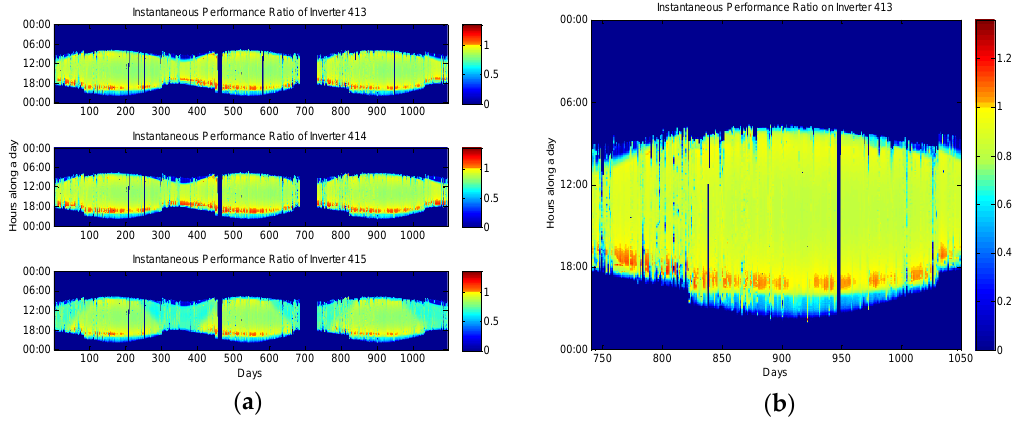
Figure 9. ( a ) Instantaneous values of performance ratio of the three inverters, during 24 h a day, from 1 January 2011 to 31 December 2013; and ( b ) enlargement of performance ratio values of inverter 413.